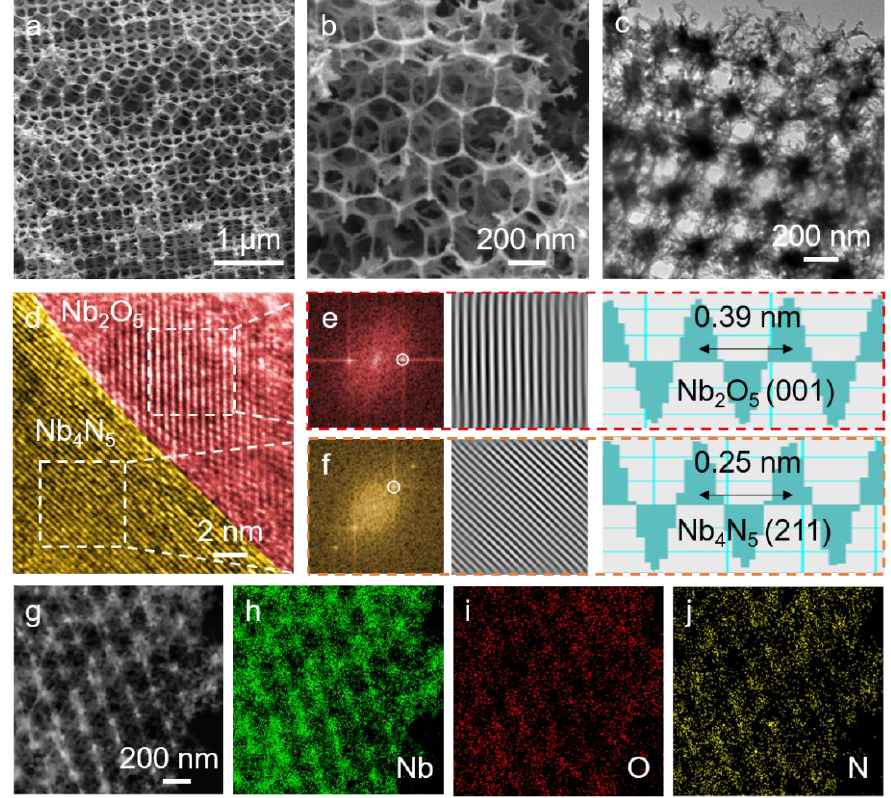
Figure 2. ( a , b ) SEM images of 3DOM Nb 2 O 5 /Nb 4 N 5 ; ( c ) TEM and ( d ) HRTEM image of 3DOM Nb 2 O 5 /Nb 4 N 5 ; ( e , f ) FFT patterns, inverse FFT patterns, and lattice spacing images of the selected area; ( g – j ) STEM image and the corresponding element distribution of 3DOM Nb 2 O 5 /Nb 4 N 5 . XRD patterns of Nb 4 N 5 , Nb 2 O 5 /Nb 4 N 5 , and Nb 2 O 5 are shown in Figure 3a; all the